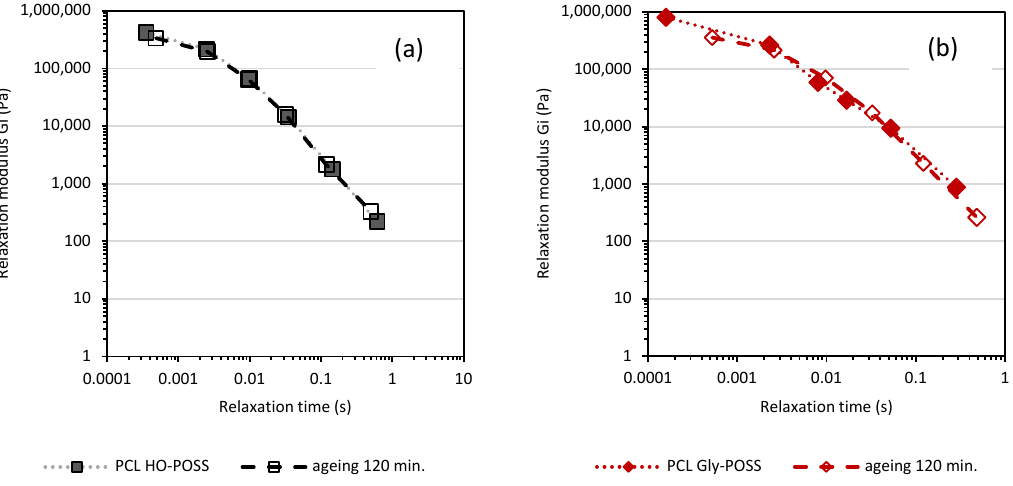
Figure 7. Discrete relaxation Maxwell’s spectra for PCL HO-POSS ( a ) and PCL Gly-POSS ( b ). Less significant changes in the values of the relaxation modulus G i and the relax- ation times λ i , recalculated based on similar angular frequency range, were observed for the PCL HO-POSS and PCL Gly-POSS composites indicating that the presence of both POSS-stabilized materials during thermo-oxidative treatment as compared with neat PCL (Figure 7). The R.M.I. (Relative Modification Index), calculated based on the measurement of complex viscosity at constant temperature, can be used to compare the influence of various additives on the degradation of the material [48]. The R.M.I. is calculated according to the below equation (Equation (6)), using the values of complex viscosity η * determined from the viscosity plateau of the η * versus angular frequency ω plots for the samples before and after thermo-oxidative ageing over 30, 60, 90, 120 min at 100 ◦ C in the presence of the oxygen from